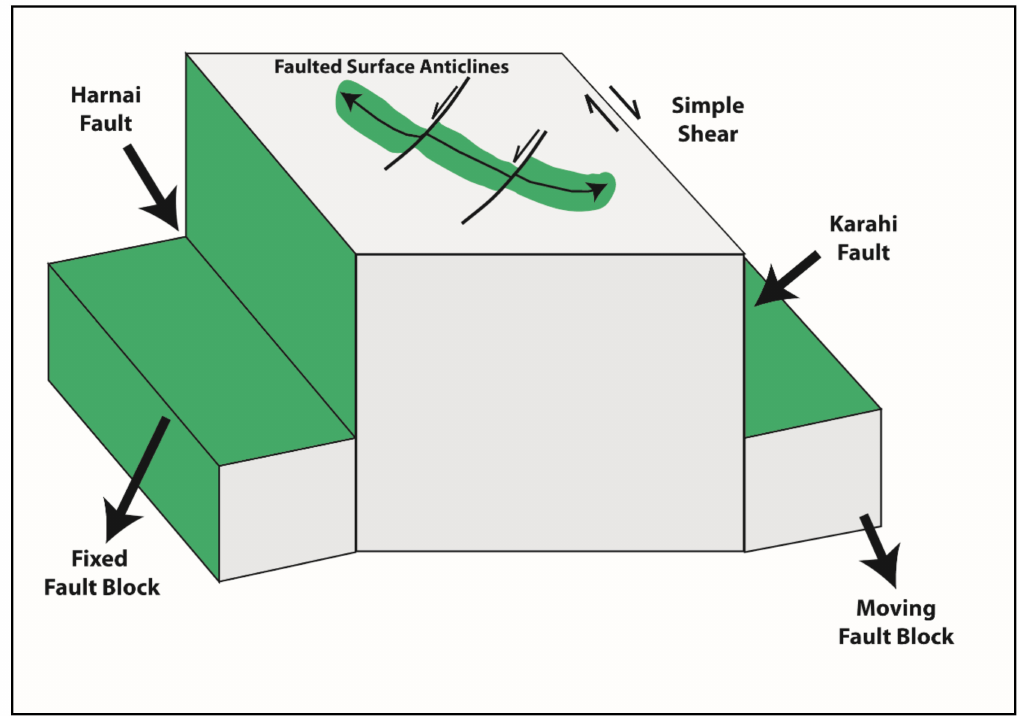
Figure 17. Diagram showing the simple shear mechanism for the right lateral shear zone [44]. The Harnai fault block is assumed to be fixed, while the Karahi fault block is moving. Due to the shearing of the Karahi Fault, the block in-between developed faulted anticlines in the form of bookshelf faulting visible on the